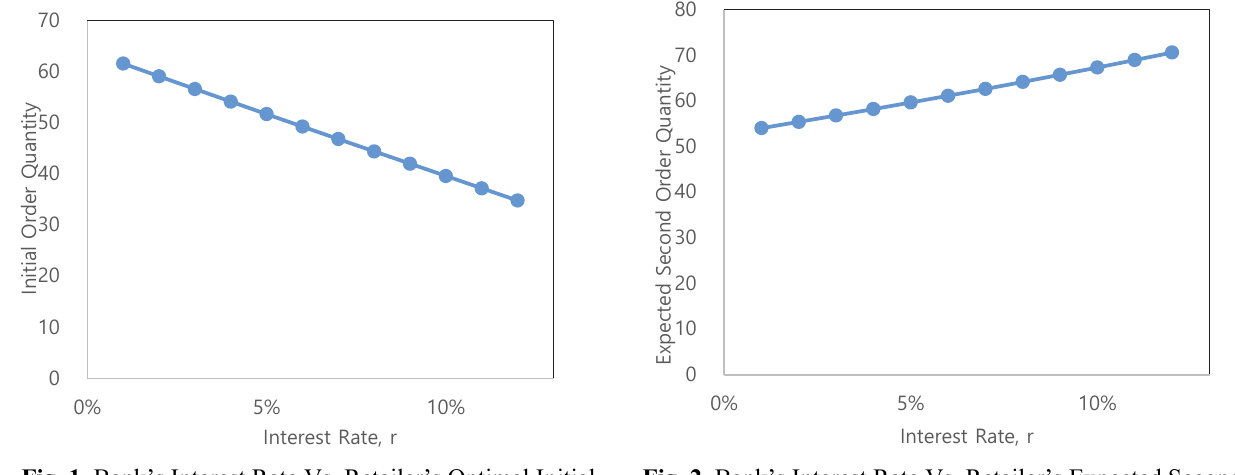
Fig. 2. Bank’s Interest Rate Vs. Retailer’s Expected Second Order Quantity